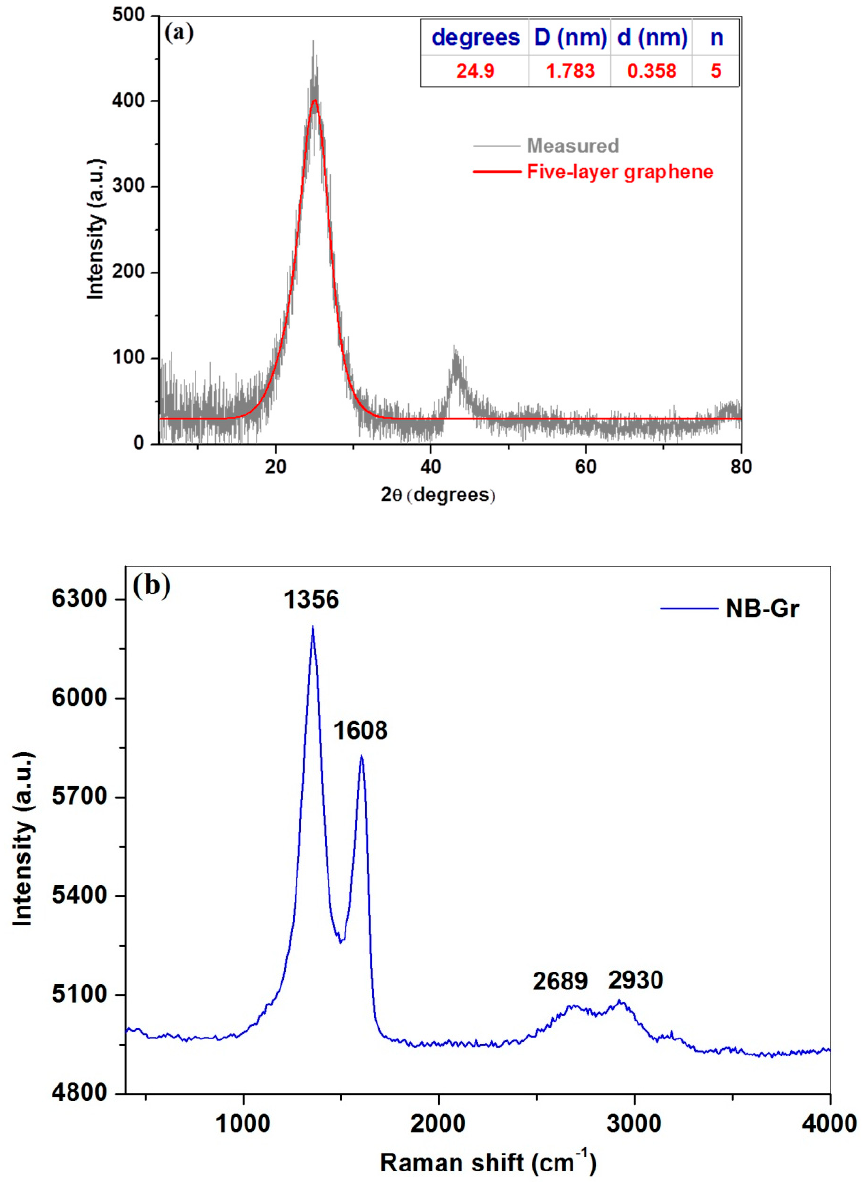
Figure 2. The XRD pattern ( a ) and the Raman spectrum ( b ) of N,B − co − doped graphene sample . The structural disorder degree in the co ‐ doped graphene sample was determined us ‐ ing Raman spectroscopy (Figure 2b). All the characteristic graphene bands are visible in the Raman spectrum of the sample: the defect (D) band at ~ 1356 cm − 1 ; the graphite band (G) at ~ 1608 cm − 1 and the 2D band at ~ 2690 cm − 1 . D band intensity is higher than the relative intensity of the G band indicating that B and N atoms were introduced into the lattice of graphene creating more defects [38]. The I D /I G ratio gives an indication of the defect ‐ free domains and is related to the in ‐ plane crystallite size (L a ) as shown by Equation (1) [39]: L (cid:2911) (cid:4666) nm (cid:4667) (cid:3404) 560 E (cid:2922)(cid:2872) (cid:3436) I (cid:2888) I (cid:2891) (cid:3440) (cid:2879)(cid:2869) (1) where E l represents the laser excitation energy (2.33 eV). The relative high intensity ratio (I D /I G = 1.066) of the NB ‐ Gr sample may be attributed to more defects generated by nitrogen and boron co ‐ doping, resulting in highly disor ‐ dered graphene nanosheets. These defects can provide considerable active sites for elec ‐ trochemical detection, as shown in the next section. To investigate the doping of N and B in the graphene, the XPS analysis was carried out (Figure 3).